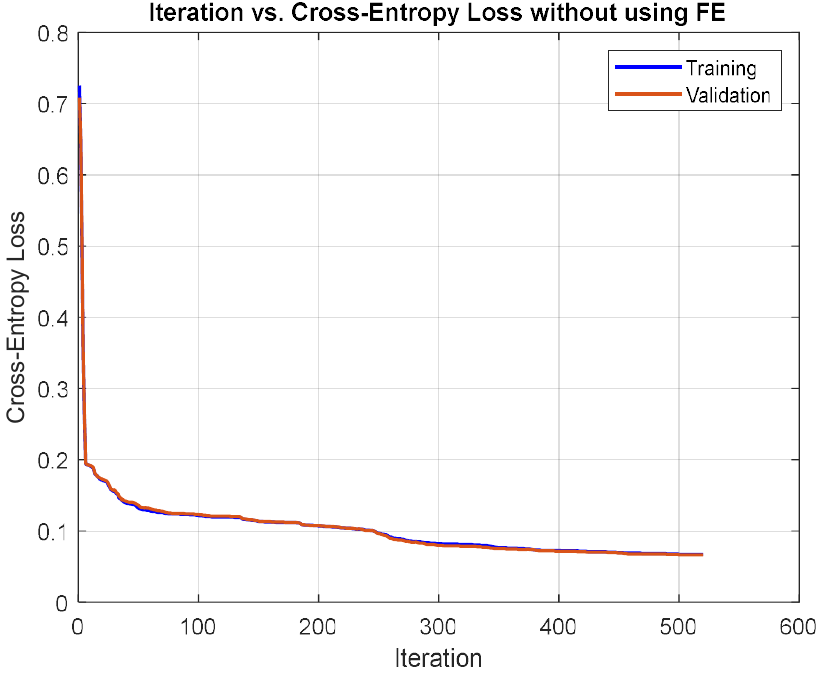
Figure 1. Iteration vs. cross-entropy loss for noisy signals with length 6400 and one hidden layer with ten nodes for DNN. Note that the error is higher than in Figure 32 and has less accuracy at 74 with more than 500 iterations.